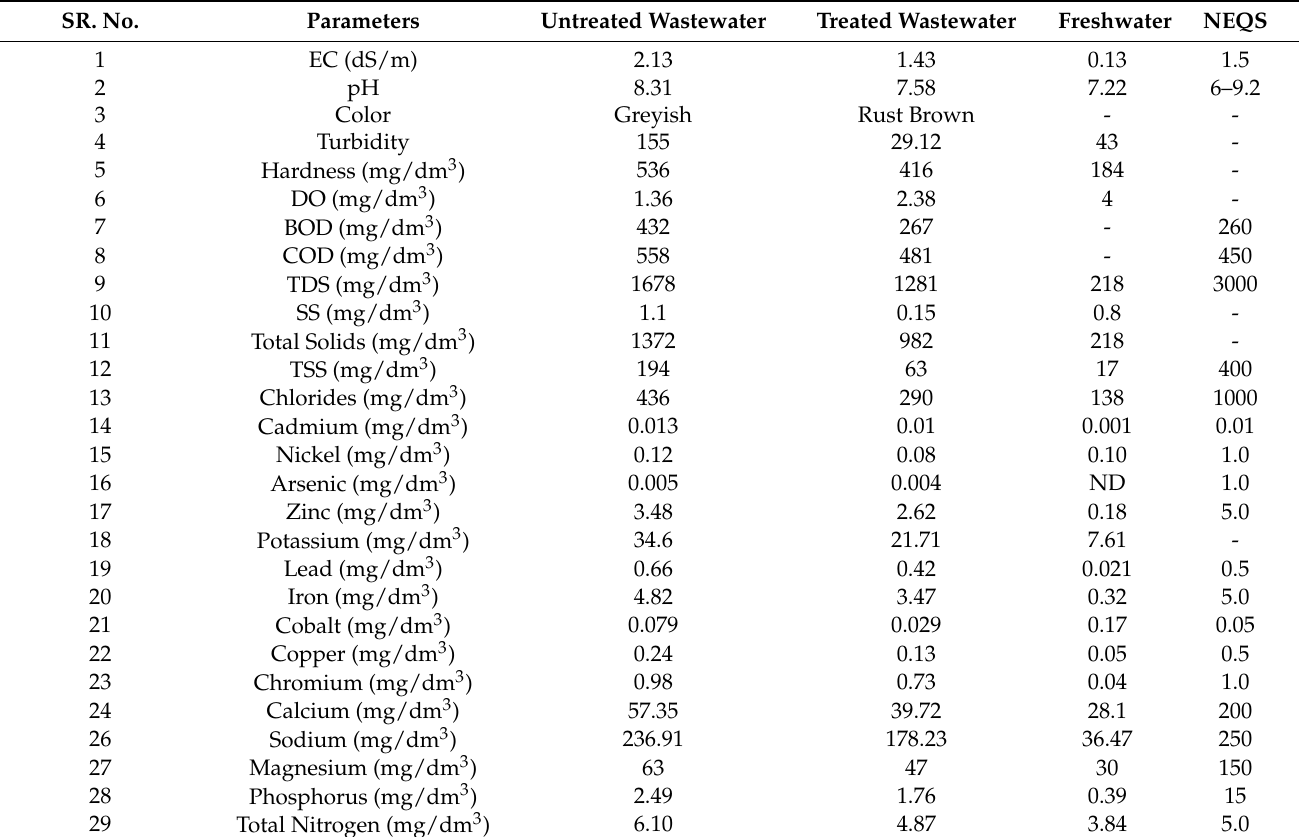
Table 2. Analysis of freshwater, treated wastewater, and untreated